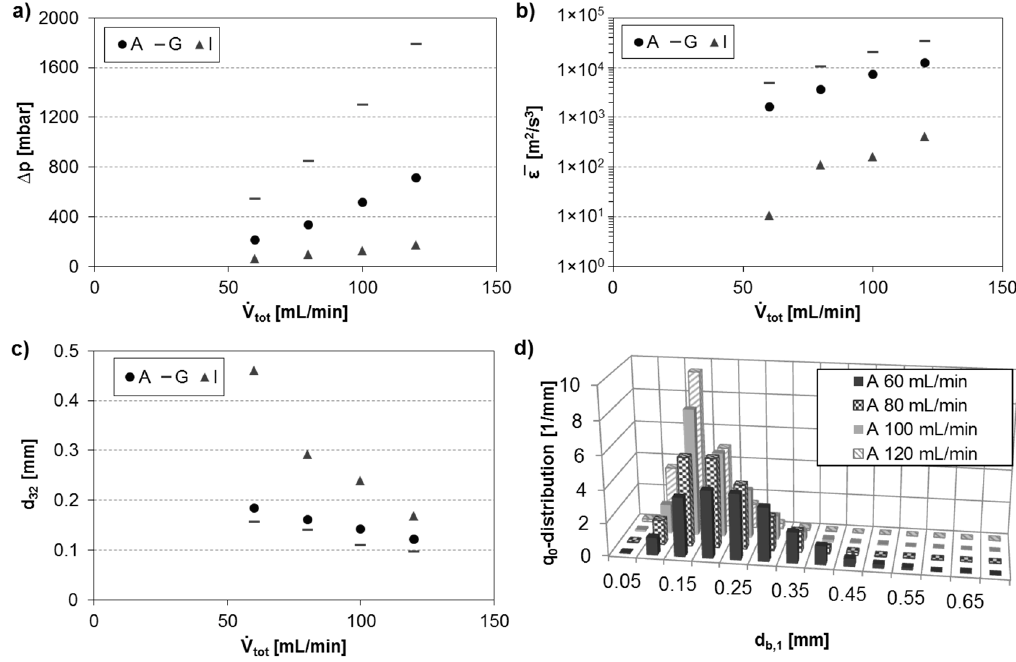
Figure 15. Impact of total volumetric flow rate on bubble breakup for varied nozzle geometries, see Table 4. Volumetric flow rates of (cid:1848)(cid:4662) (cid:3047)(cid:3042)(cid:3047) = 60, 80, 100, and 120 mL/min are used at void fraction of 0.1 for each nozzle inlay. ( a ) Obtained pressure drop plotted over total volumetric flow rate for nozzle inlays A, G, and I; ( b ) mean energy dissipation rates plotted over total volumetric flow rate for nozzle inlays A, G, and I; ( c ) obtained Sauter diameter of dispersed bubbles plotted over total volumetric flow rate for nozzle inlays A, G, and I; ( d ) bubble density distribution for nozzle inlay A at various total volumetric flow rates.